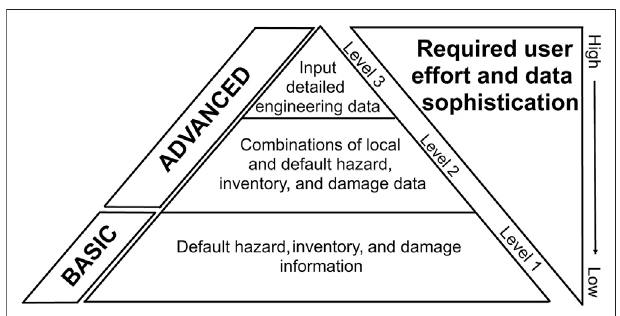
FIGURE 1 | Schematic of information involved in each level of Hazus (modi fi ed from FEMA